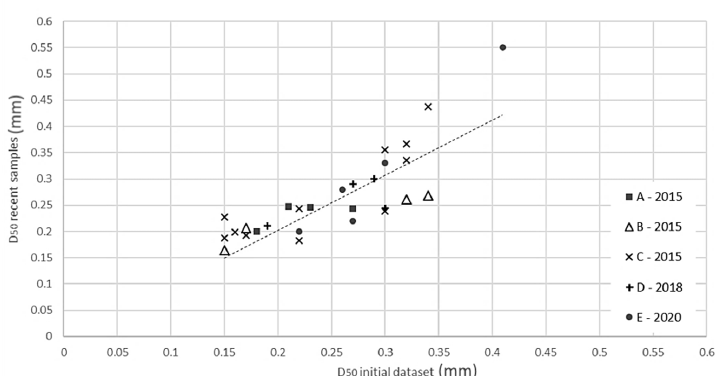
Figure 5. Comparison of the median grain size of the samples composing the original and the